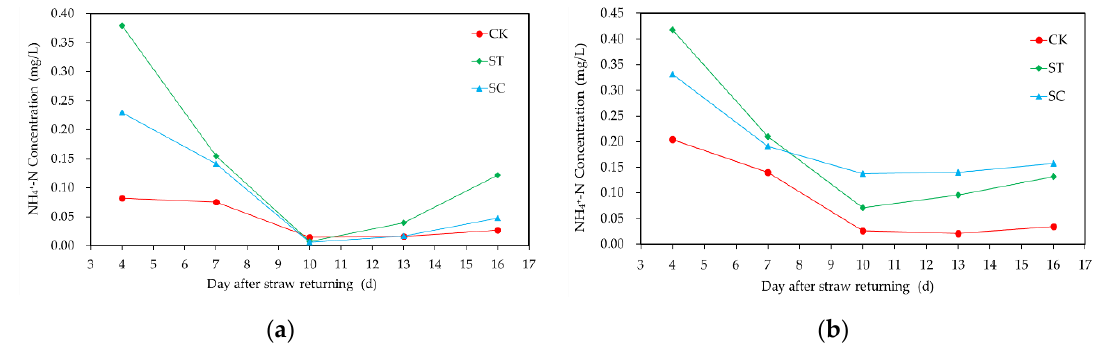
Figure 3. Characteristics of NH 4+ -N concentration in field water with different treatments: ( a ) surface water; and ( b ) 0–10 cm soil water.